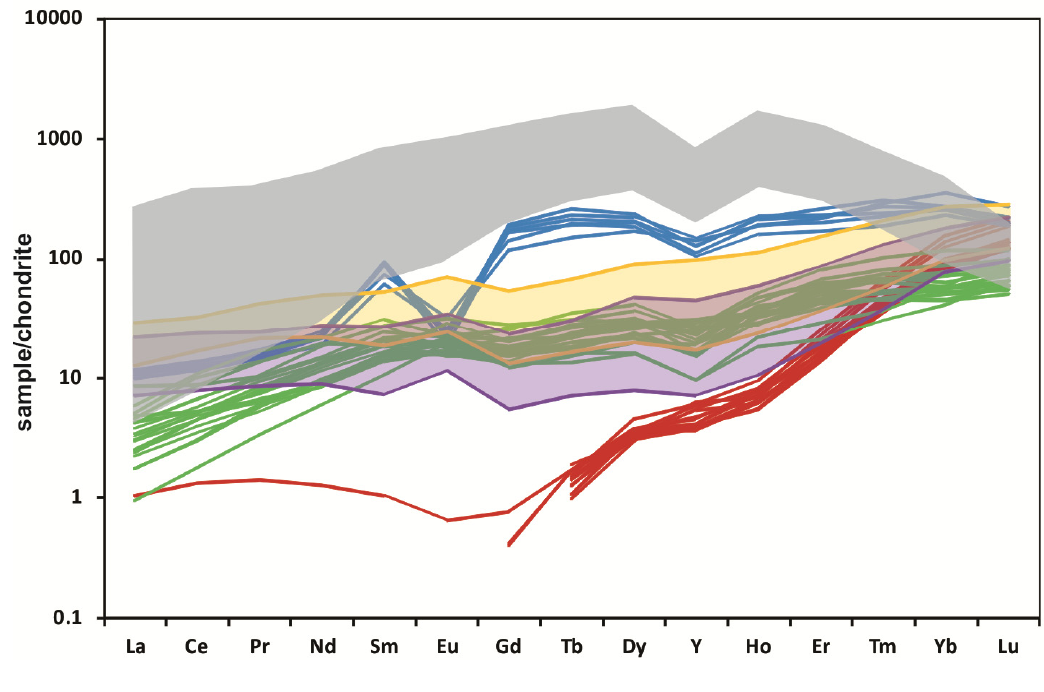
Figure 9. Chondrite-normalized rare earth elements (REE) patterns of 40 analyses of ferberite (type-1 = red, type-2 = green, type-3 = blue) from two polished sections (polished section 1 and 2) from the Bugarama deposit and the distribution of chondrite-normalized REE patterns for the 25th and 75th percentile of ferberite analyses in ore concentrates from the Gifurwe (purple) and Nyakabingo (yellow) deposits. For comparison, chondrite-normalized REE patterns of hydrothermal scheelite (grey) are generalized from the data given for hydrothermal scheelite in the literature [48,49]. Please note that the chondrite-normalized data are displayed on the logarithmic scale. The composition of C1 carbonaceous chondrite is taken from McDonough and Sun